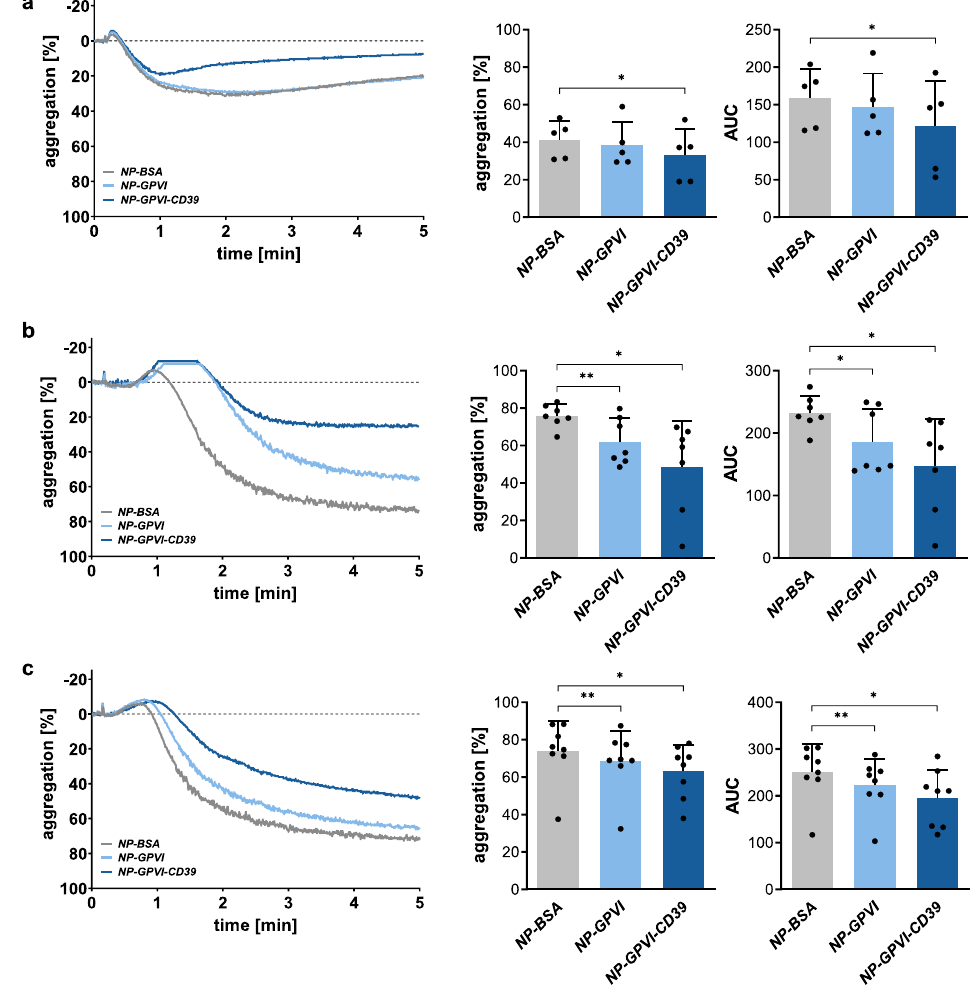
Figure 6. Receptor-coated nanoparticles inhibit platelet aggregation in light transmission aggregometry. Left : Representative light transmission aggregation curves of PRP activated by the three different platelet activators, ADP ( a ), collagen ( b ) and CRP ( c ). Right : Statistical analysis of maximum aggregation and AUC. Mean ± SD; ADP: n = 5, Collagen: n = 7, CRP: n = 8; one-way ANOVA; * p ≤ 0.05, ** p ≤ 0.01.